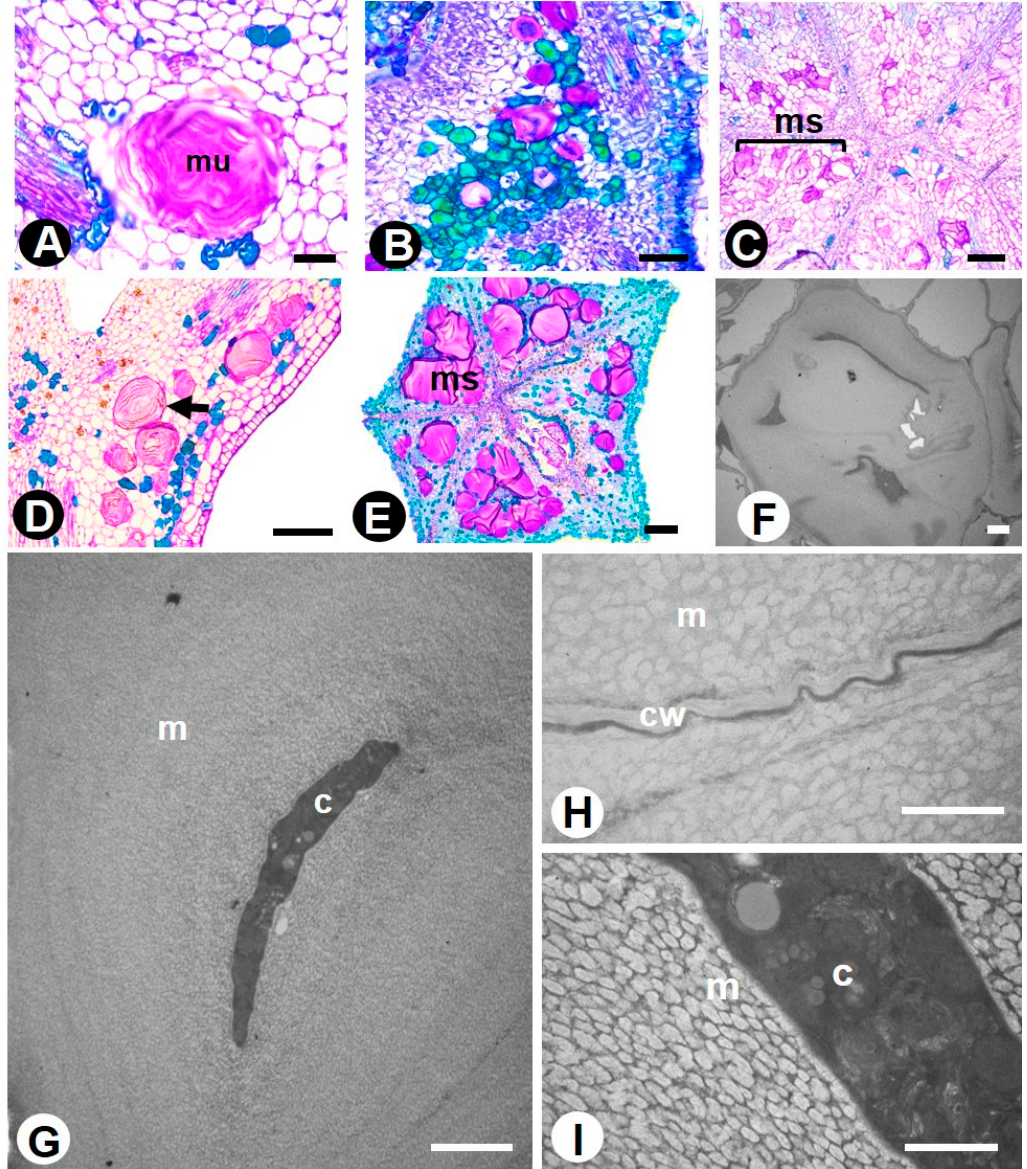
Figure 4. Mucilaginous idioblasts in the flower of Rhamnaceae species. ( A – E ) = LM, ( F – I ) = TEM. ( A , B , D ) = longitudinal sections, ( C , E ) = transverse sections. ( A ) Colubrina glandulosa —mucilaginous idioblast in the hypanthium parenchyma. ( B ) Gouania virgata —a cluster of mucilaginous idioblasts in the sepal mesophyll, as well as phenolic idioblasts in green. ( C ) Sarcomphalus joazeiro —a cluster of mucilaginous idioblasts forming a mucilage system. ( D – F ) Hovenia dulcis— mucilaginous idioblasts in the hypanthium parenchyma (arrow). ( F ) Dissolution of cell walls of adjacent cells and mucilage accumulation causing the cytoplasm restricted to the cell center. ( G – I ) Rhamnidium elaeocarpum —detail of a mucilage idioblast in the sepal mesophyll. Note that the same process of mucilage storage (dissolution of the cell wall and central cytoplasm) occurs. Symbols: c = cytoplasm, cw = cell wall, m = mucilage, ms = mucilage system. Scale bars: ( A , B ), 50 μ m; ( C – E ), 100 μ m; ( F ), 10 μ m; ( G , H ), 2 μ m; I, 3 μ m.